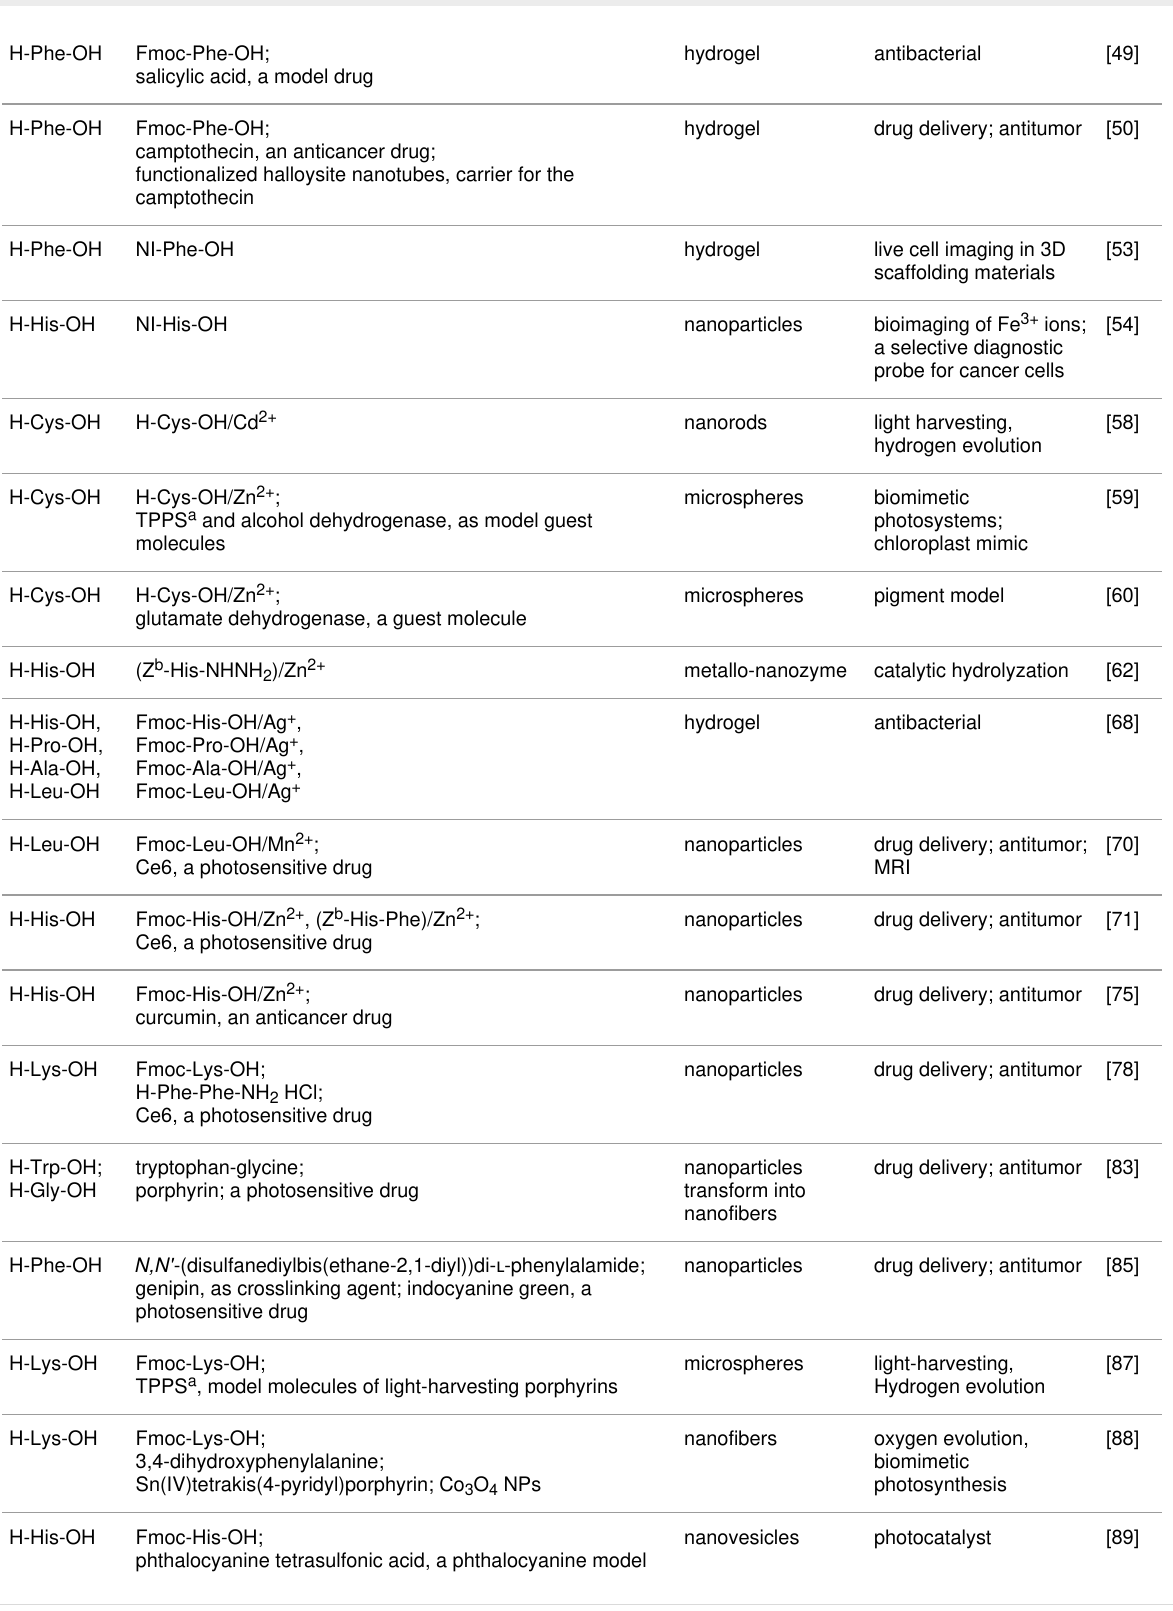
Table 1: Summary of amino acids/amino acid derivatives and their applications. (continued)